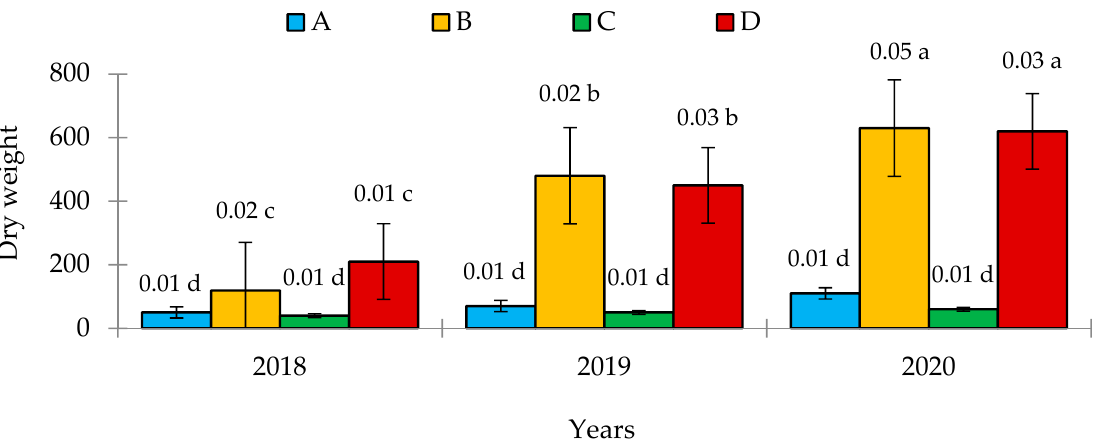
Figure 3. Dry weight of nodules (mg) during the flowering stage. A—control (seeds without coating), B—inoculated seeds: HiStick ® Soy, C—coated seeds: chitosan + alginate/PEG, D—B + C. Mean values with different letters (a–d) are statistically different at p < 0.001. The numbers on the bars indicate the standard error (SE).